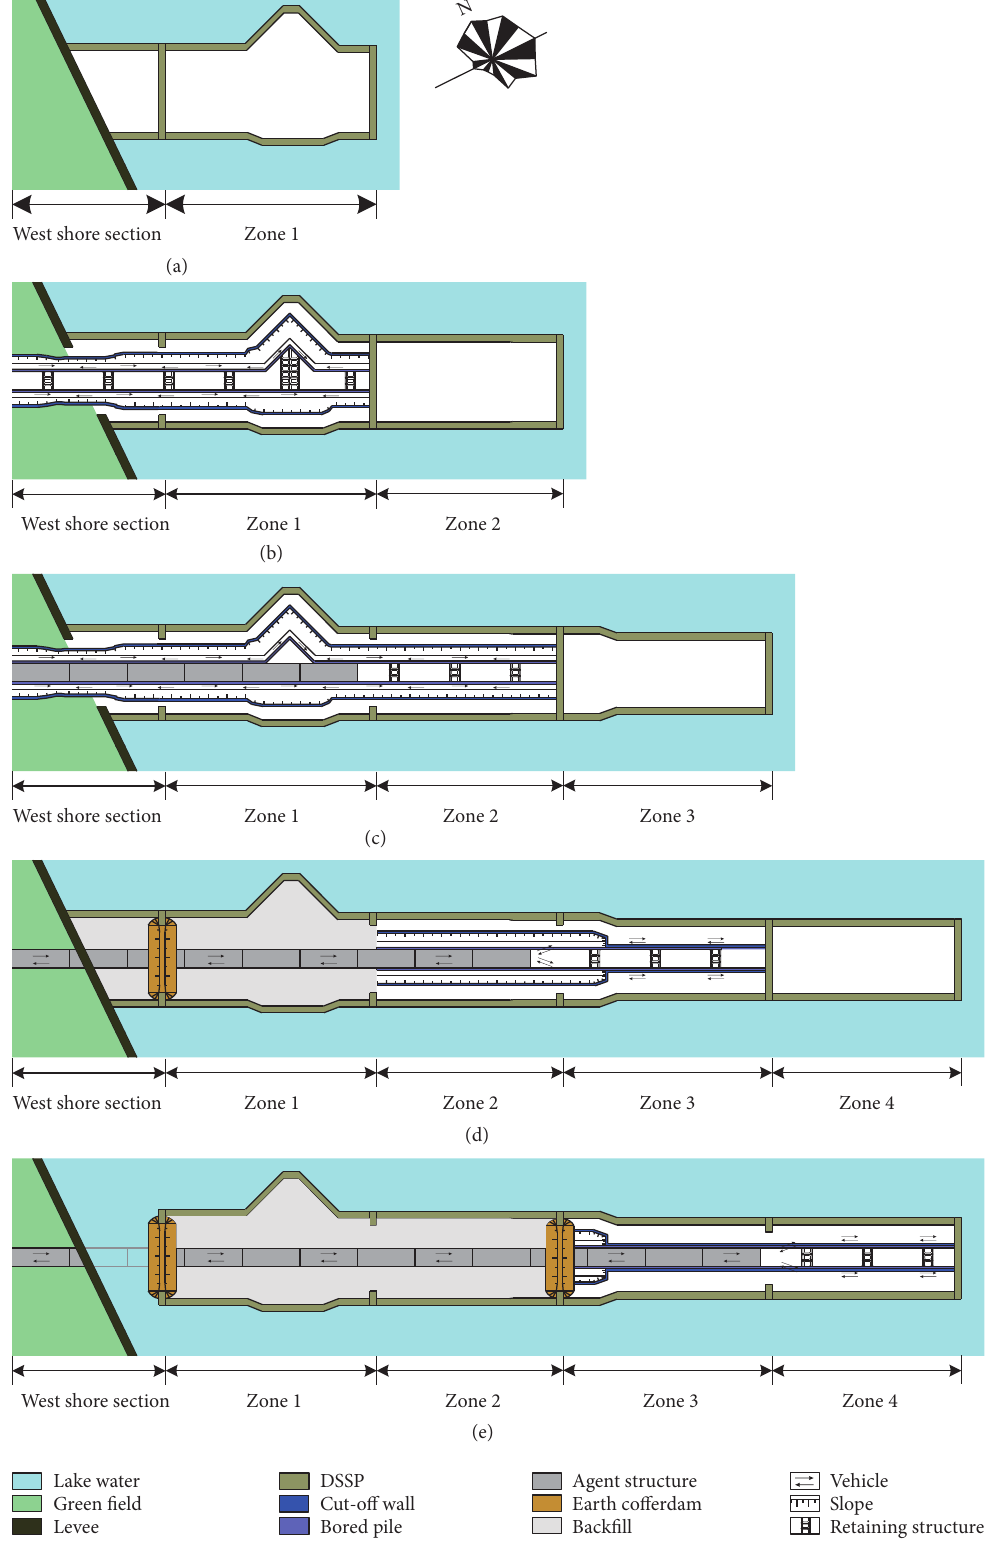
Figure 4: Schematic diagram of the novel construction method. (a) Step 1, (b) Step 2, (c) Step 3, (d) Step 4, and (e) Step